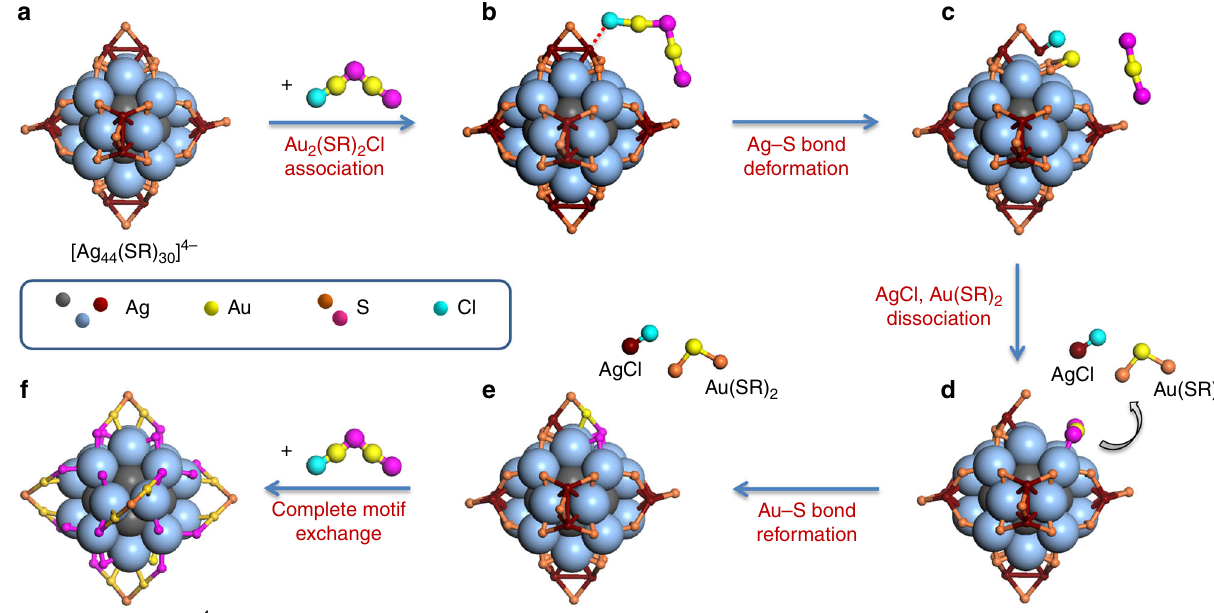
Fig. 6 Schematic illustration of surface motif exchange reaction on Ag 44 nanoclusters. a Pristine [Ag 44 (SR) 30 ] 4 − ; b association of [Au 2 (SR ′ ) 2 Cl] − to [Ag 44 (SR) 30 ] 4 − ; c Ag – S bond deformation in [Au 2 (SR ′ ) 2 Cl] − associated [Ag 44 (SR) 30 ] 4 − ; d dissociation of AgCl and [Au(SR) 2 ] − ; e [Ag 43 Au(SR) 28 (SR ′ ) 2 ] 4 − formed by exchange of one SR – Ag(I) – SR motif and f [Ag 32 Au 12 (SR) 6 (SR ′ ) 24 ] 4 − produced by complete exchange of twelve SR – Ag(I) – SR motifs, where SR and SR ′ denote pristine and foreign thiolate ligands, respectively. For an easy and clear presentation, the Ag atoms in Ag 12 inner core and Ag 20 external core are shown as gray and light blue large balls, respectively; while the other atoms are shown as small dots (color legend: Ag (gray/light blue/purple), Au (yellow), S (orange/magenta), and Cl (light green)). The hydrocarbon tails and carboxylic groups of the protecting ligands are omitted